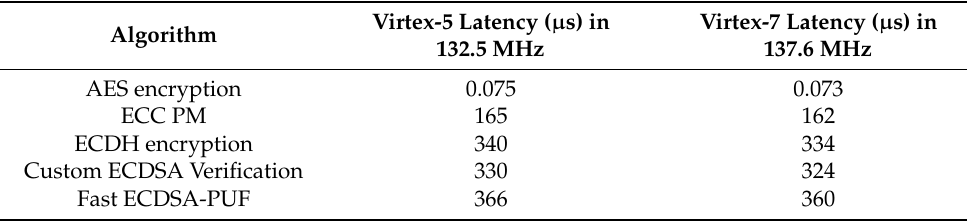
Table 4. Image encryption subsystem speed results under FPGA implementation.